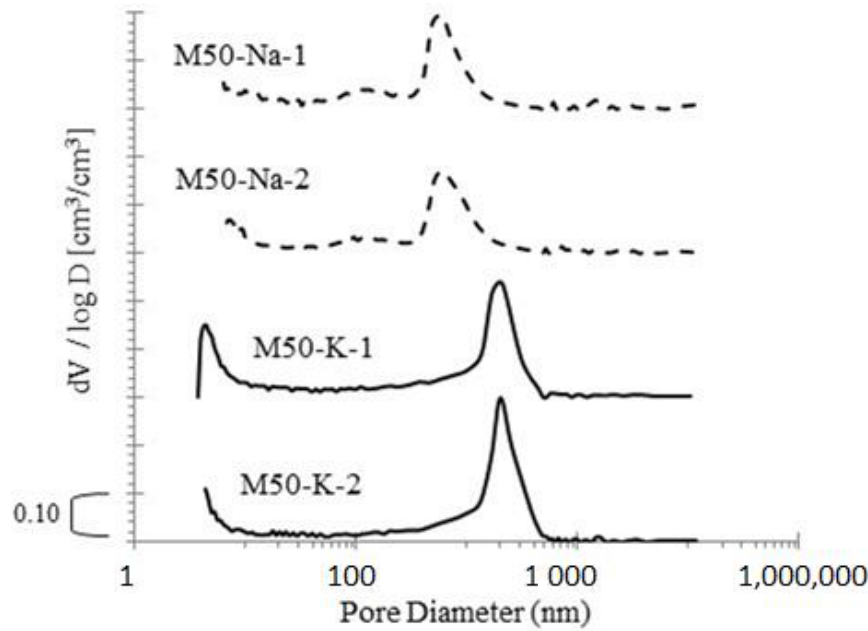
Figure 5. Comparison of critical pore diameter for M50-K and M50-Na materials.